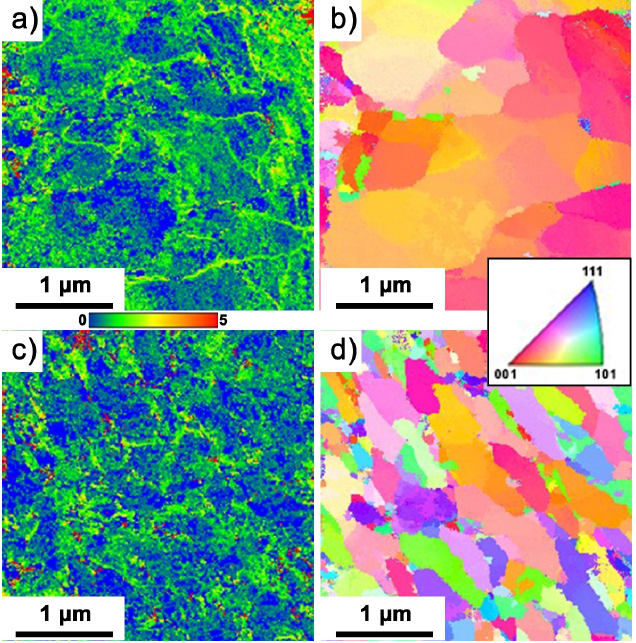
Figure 7. Lattice distortion for tubes processed with stationary ( a ) and rotating ( c ) mandrel and corresponding OIM maps colorized according to IPF for stationary ( b ) and rotating ( d ) mandrel. The results in Figure 7 agree well with previous results obtained from EBSD measure- ments. Larger subgrains of the size frequently exceeding 1 μ m divided by very low-angle boundaries were found in the sample processed with stationary mandrel. The microstruc- ture of the sample processed with rotating mandrel is composed of submicrometer grains divided predominantly by HAGBs. The grains are elongated, and the mean sizes evalu- ated by the same method as from EBSD are 800 nm and 400 nm, respectively, i.e., identical with data estimated from EBSD. Figure 8 displays the real microstructures of both samples. Elongated subgrains with a length of about 1 μ m were found in the sample processed with stationary mandrel (Figure 8a). The area denoted by a red circle in Figure 8b is shown as dark field image in Figure 8c formed by the selected diffracted beam on the inset in Figure 8b. It reveals that subgrains form grains with a size of several micrometers. The area denoted by a red square in Figure 8b was in- vestigated at higher magnification (Figure 8d) and the presence of dislocations predomi- nantly arranged into dislocation walls and subgrain boundaries was observed.